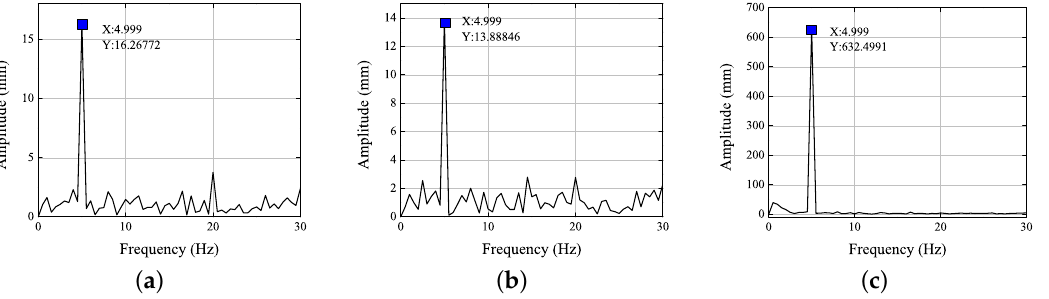
Figure 9. Frequency spectra of left eye in the ( a ) X , ( b ) Y , and ( c ) Z directions.